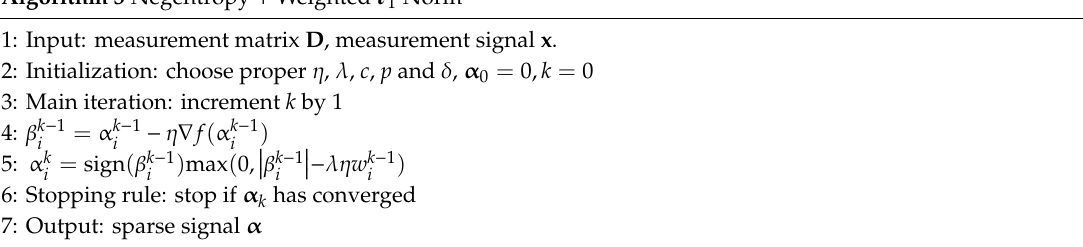
Algorithm 3 Negentropy + Weighted (cid:96) 1